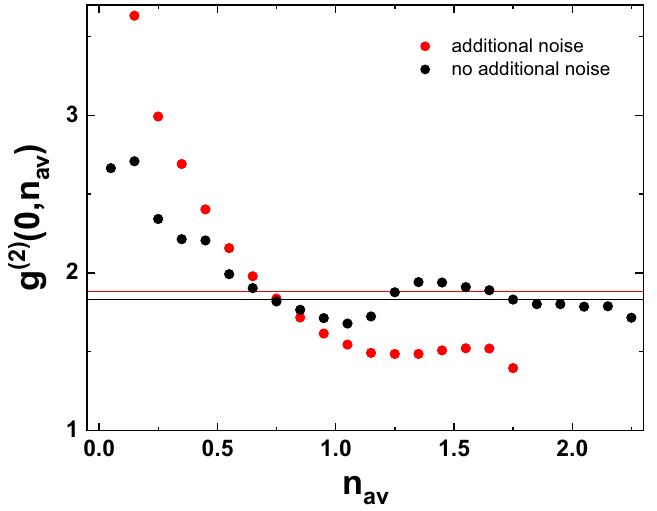
Figure 6. Postselected second-order correlation function g ( 2 ) ( 0, n av ) for several mean postselection photon numbers n av at an averaging frequency of 75 kHz. Black and red dots denote the correlation functions in the absence and presence of deliberately added mechanical noise, respectively. Solid lines represent the values of g ( 2 ) ( 0 ) obtained for the same averaging frequency without performing any